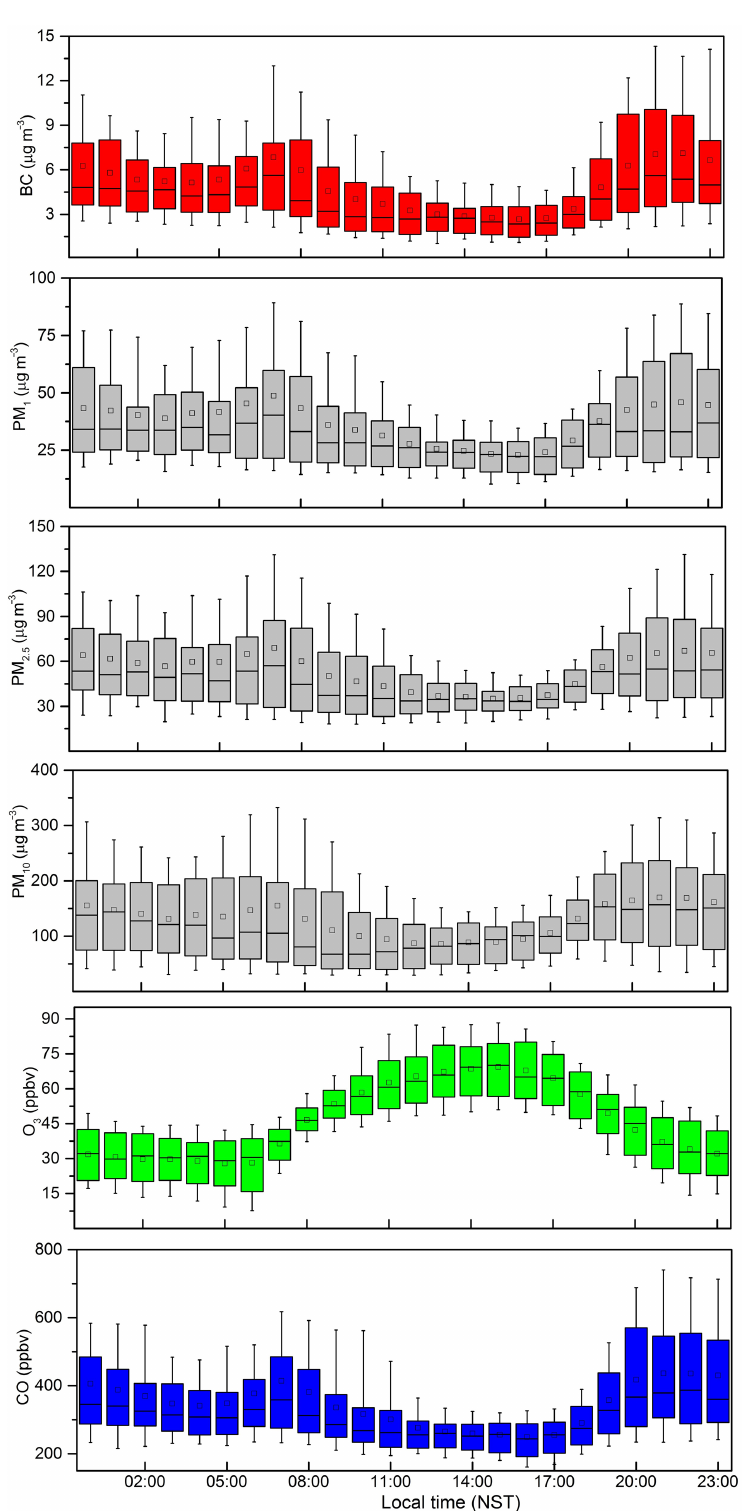
Figure 5. Diurnal variations of hourly average ambient concentrations of BC, PM 1 , PM 2 . 5 , PM 10 , O 3 and CO at Lumbini during the monitoring period (1 April–15 June 2013). In each box, the lower and upper boundary of the box represent the 25th and 75th percentile, respectively; the top and bottom of the whisker represent the 90th and 10th percentile, respectively; the mid-line represents the median; and the square mark represents the mean for each